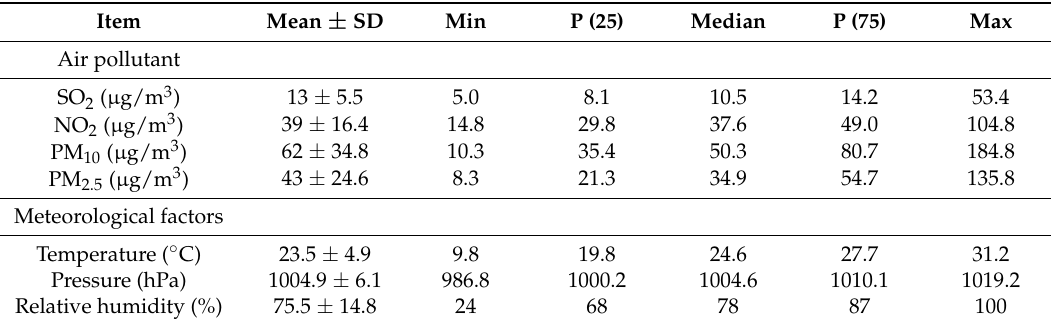
Table 2. Descriptive statistics for air pollutants and meteorological factors for Shenzhen